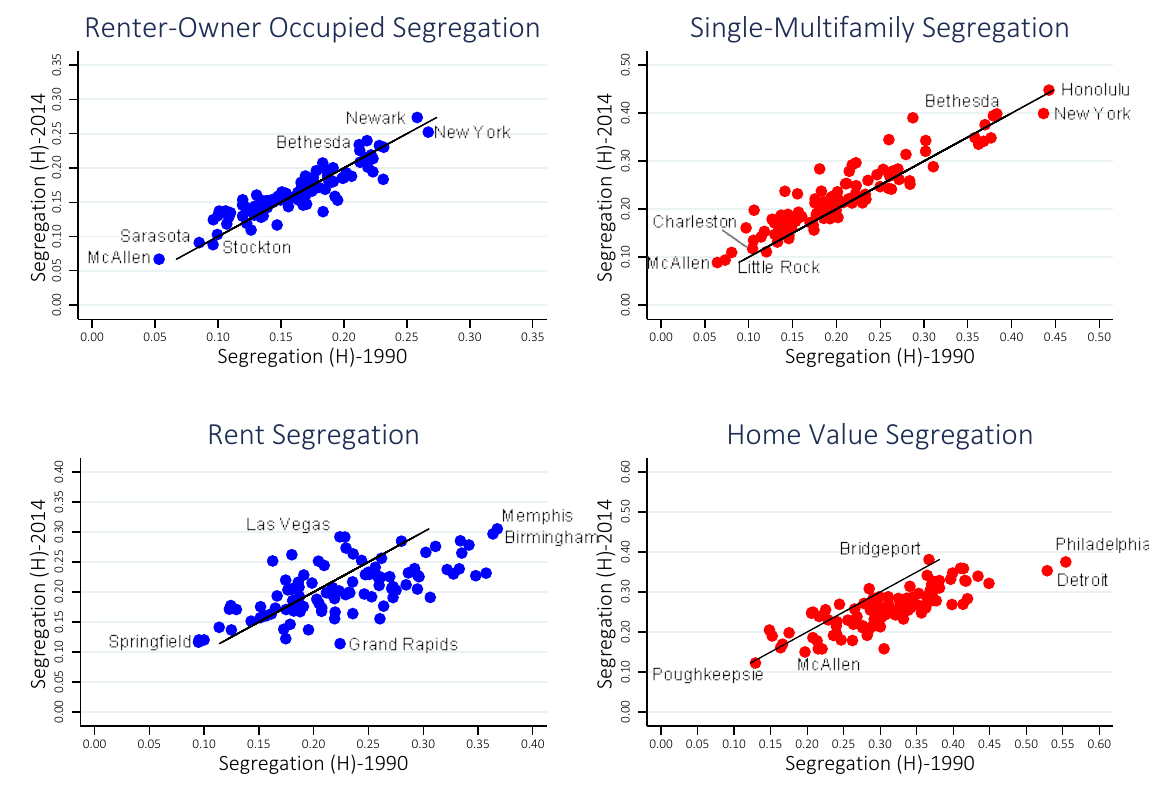
Figure 1: Housing segregation between neighborhoods in 1990 and 2014, 100 largest metropolitan areas. expensive rental homes (dark-red dots) cluster on the east edge of the city and the adjacent areas to the west, with a concentration of low-cost rental housing (gray dots) in the center of the city. In contrast, although there is some spatial clustering in Grand Rapids, low- and high-cost rental housing share many neighborhoods in the center of the city and outlying